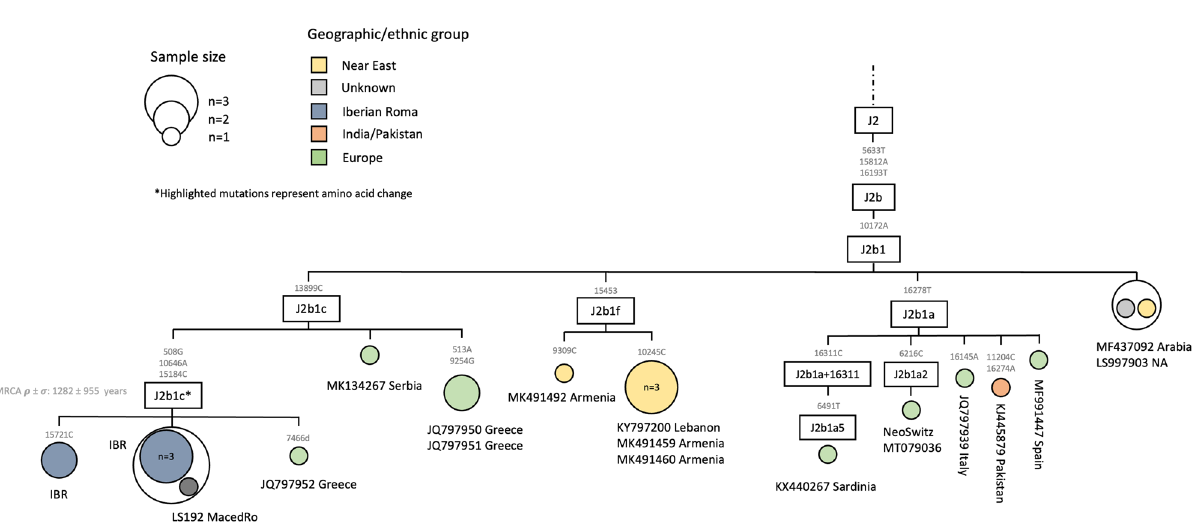
Figure 5. Maximum parsimony tree of the haplogroup J2b1c* Roma mitogenomes. The mtDNA variants are indicated along the branches of the phylogenetic tree. The highlighted mutations represent non-synonymous mutations. The IBR tag refers to Iberian